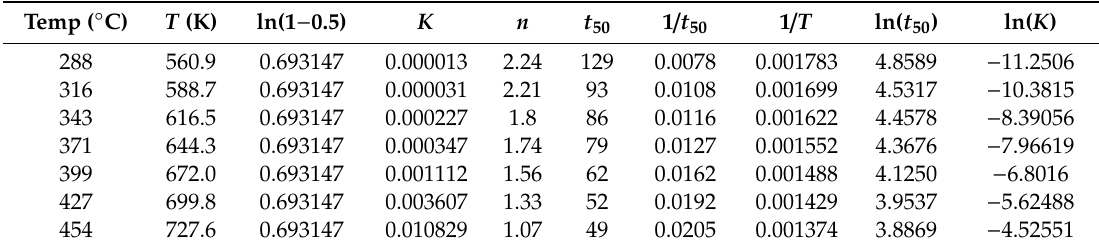
Table 5. Data used for calculating activation energy of bainite